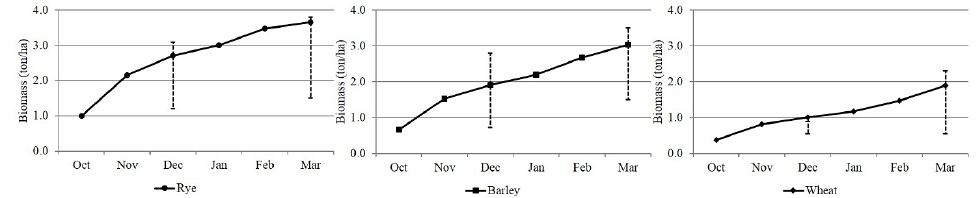
Figure 5. Estimation of winter cover crop biomass during the winter fallow period. Note: This figure presents monthly average total biomass (both above- and below-ground biomass) over the simulation period for three planting species obtained at the field (HRU) scale. The vertical dotted line represents the range of above-ground biomass estimates due to different growing/planting days from Hively et al. (2009). The simulated total biomass lies at the upper end of above ground biomass estimates.